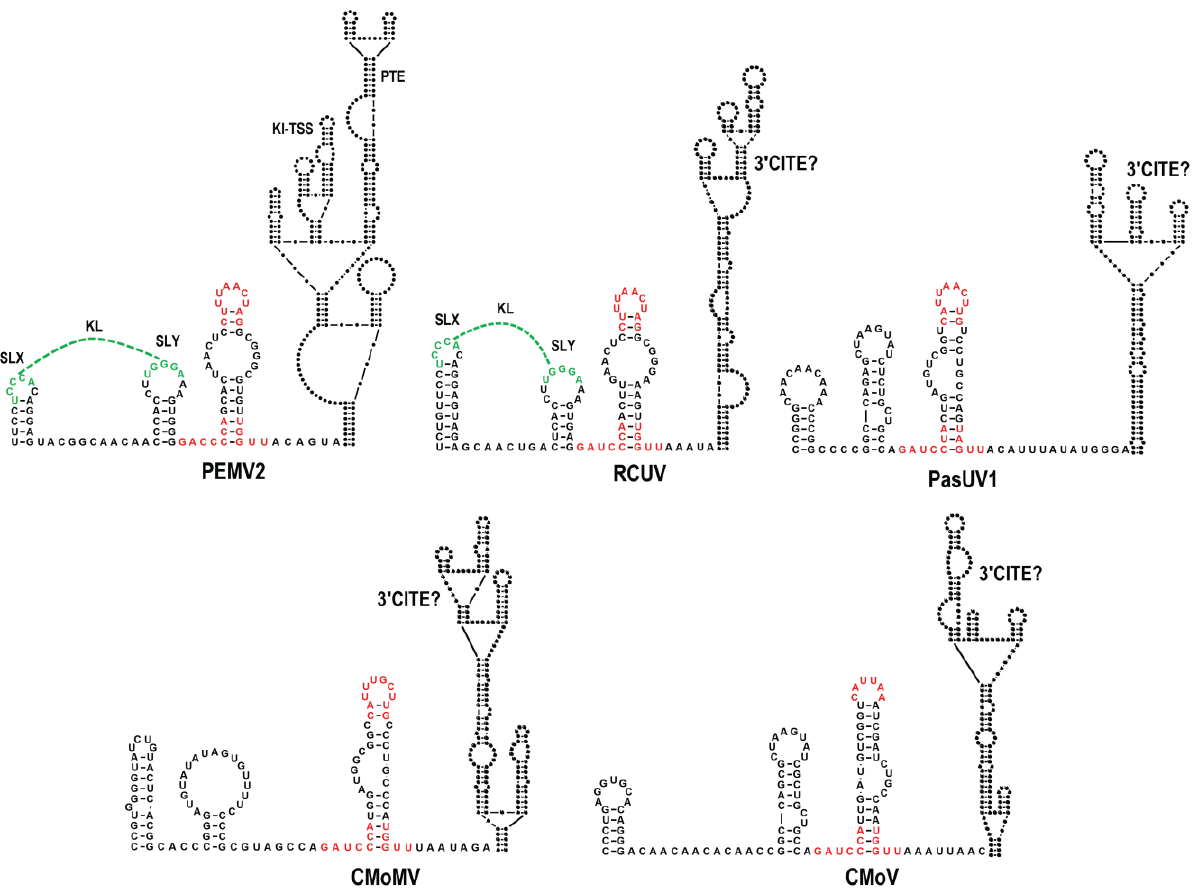
Figure 3. Predicted structures in the central region of umbraviruses containing non-BTE 3 (cid:48) CITEs. Conserved CAS sequences are in red. KL sequences are in green. Putative 3 (cid:48) CITEs are denoted by a question mark.